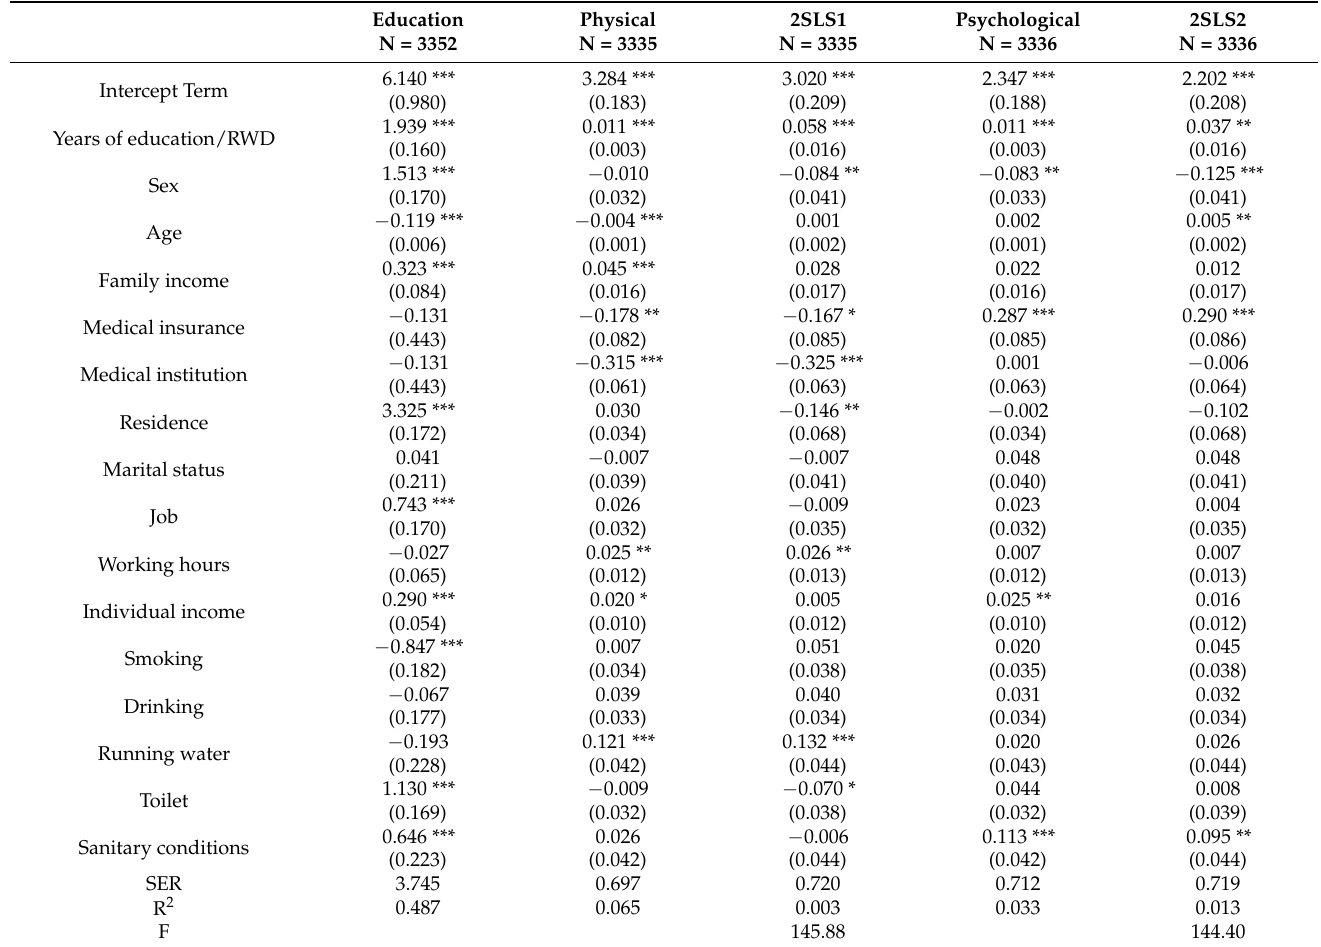
Table A4. Results obtained from ordinary least squares and two-stage least